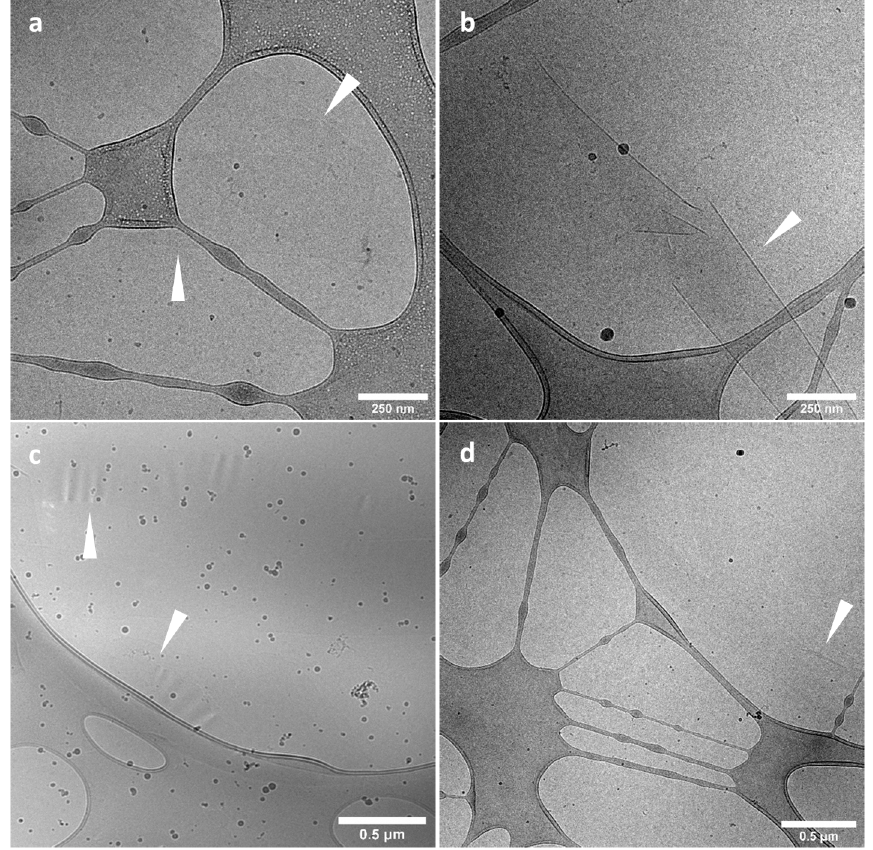
Figure 13. Cryo-TEM images ( a – d ) of the StarP aggregates in water solution. Therefore, thanks to their shape, these supramolecular ribbons could act as flags dur- ing the interaction with the thermophoretic fields: their large surface could intercept sev- eral asymmetric flows, different in strength, which modify their supramolecular shape in a chiral way. Because these microscopic aggregates change their supramolecular chirality under the asymmetric solicitations and lose it when the thermal flows cease [29], seeming to ex- hibit elasticity [55] when thermal ramps are applied in solution, the macroscopic structure could stretch and/or twist under a weak external stimulus reversibly. Given the reported results, it emerges that aggregate size is certainly important in determining the CD response to asymmetric perturbations, but also the shape and mor- phology play a significant role. In particular, the existence of large thin aggregates pos- sessing a certain degree of flexibility (mainly due to weak supramolecular interactions among the building blocks, like hydrophobic, π - π , and hydrogen bond) is a strong requi- site. We hypothesize that the flat supramolecular ribbons, in stagnant solution and fine- thermostated conditions, have statistical local deformations that are reflected in the ab- sence of circular dichroism signal. Instead, when thermal ramps are applied in solution, the macroscopic structure could have, dynamically and reversibly, local asymmetric de- formations. The handedness excesses of these deformed areas consequently result in a transient partial offset orientation excess of porphyrin-based building blocks [56], which is reflected in the recorded circular dichroism signal. Contrarily, the nanoscopic structures are just directing by the directions of the flow (as the Brownian motions) [30]. Taking into account previous investigation on modified-pyrene achiral aggregates [31], the data here reported support the hypothesis that the CD response to asymmetric